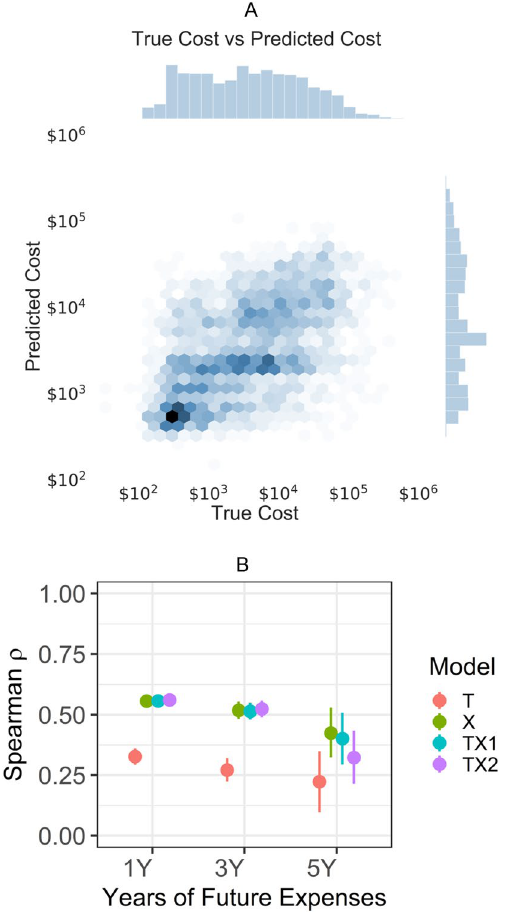
Figure 3. ( A ) Joint distribution hex plot for the TX2 (modified ResNet with all features trained end to end) prediction model. The histogram on x-axis shows log 10 of the true cost. The histogram on y-axis shows log 10 of the predicted cost. ( B ) Whisker plot of Spearman ρ for order-of-magnitude prediction within 1, 3, and 5